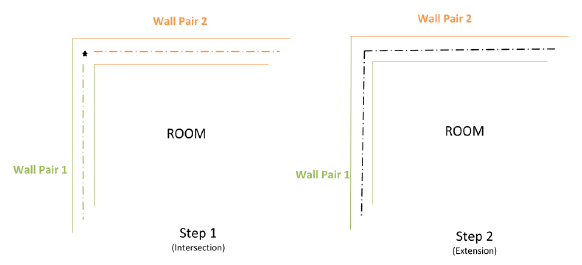
Figure 4. Centre line extension